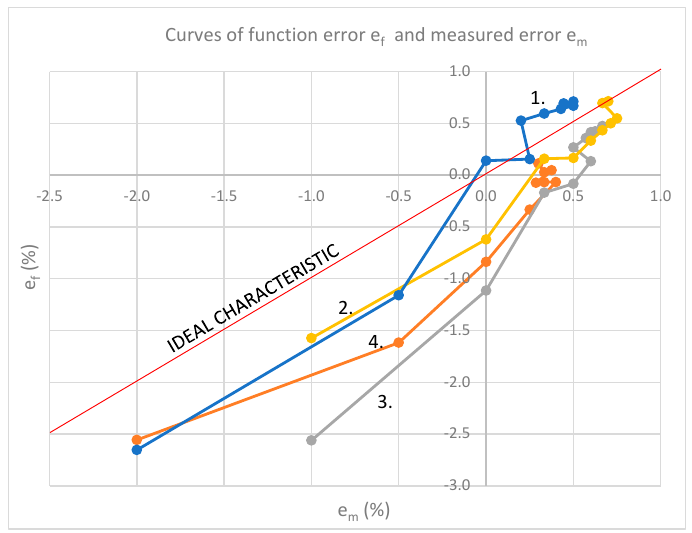
Figure 14. Curve: 1 . f = 50 Hz; R 2 = 0.9657, 2. f = 100 Hz; R 2 = 0.9607, 3. f = 150 Hz; R 2 = 0.9727, 4. f 2 = 0.9657, 2 . f = 100 Hz; R 2 = 0.9607, 3 . f = 150 Hz; R 2 = 0.9727, 4 . = 200 Hz; R 2 = 0.916. Figure 14. Curve: 1. f = 50 Hz; R f = 200 Hz; R 2 =